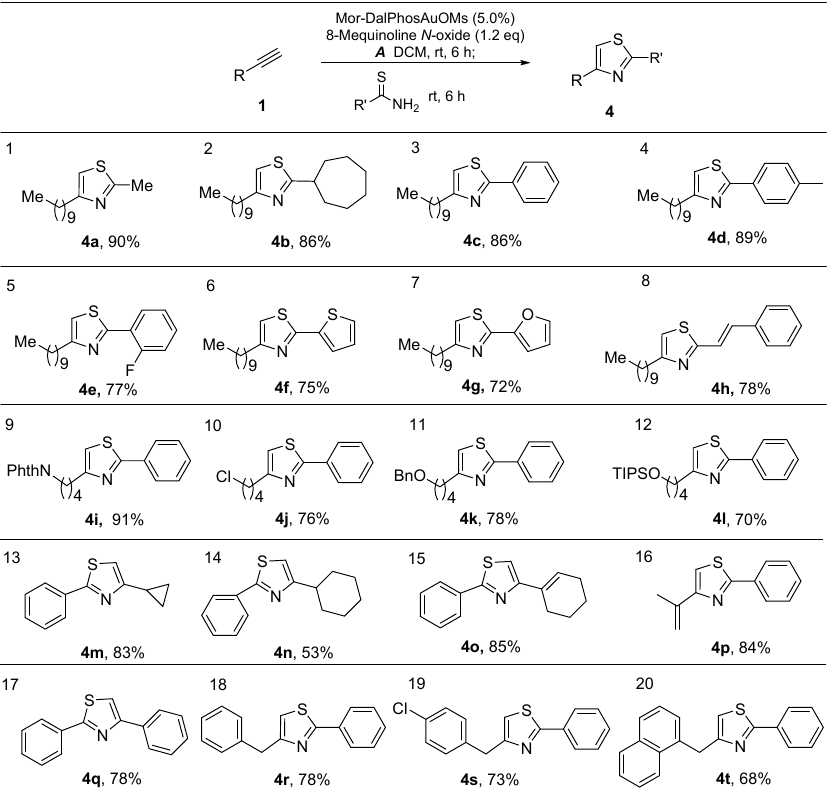
Figure 3. One-pot synthesis of 2,4-disubstituted thiazoles a . a Isolated yields; Reaction condition: 1 ‐ dodecyne, 5 mmol; A , 1.2 eq.; Oxidants, 1.2 eq.; thioamide, 1.2 eq.; DCM, 5 mL; Room temperature (25 °C).